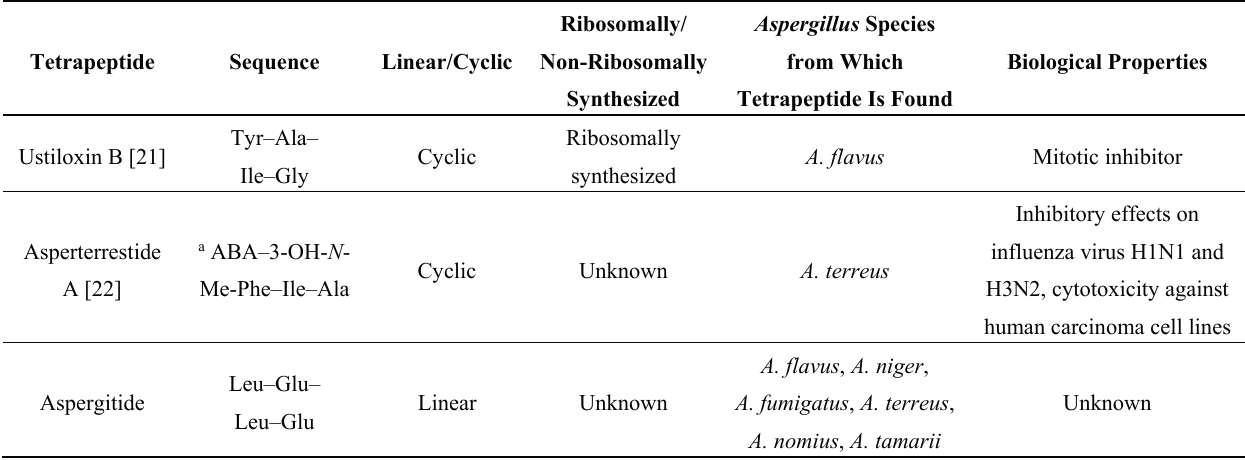
Table 2. Known tetrapeptides in Aspergillus